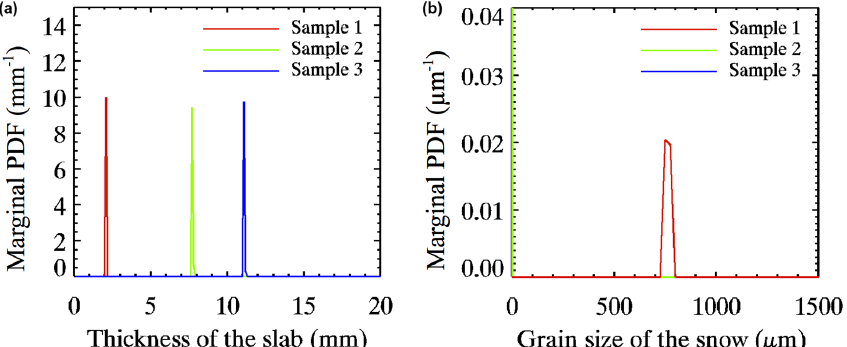
Figure 14. Marginal a posteriori probability density functions for (a) the thickness of the slab P { p 1 (i) } and (b) the grain diameter of the snow substrate P { p 2 (j) } for the three